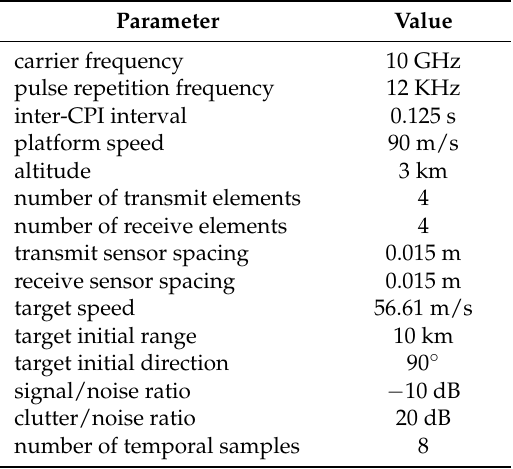
Table 1. Simulation